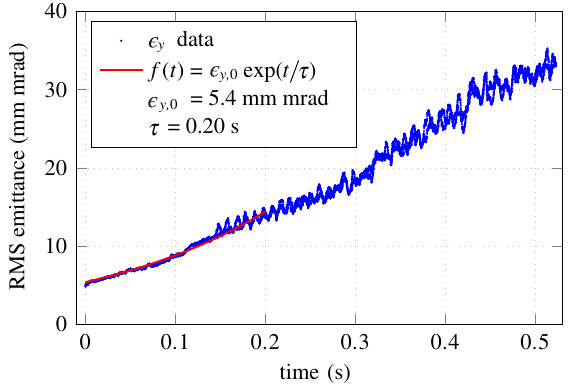
FIG. 20. Growth of the RMS emittance as a result of bunch length jitter as obtained from the tracking simulation. The growth time τ and the initial emittance ϵ y; 0 are free parameters. The curve fit only uses data with t < 0 . 2 s to avoid excessive errors due to the artificially restricted emittance growth of lost shows the evolution of the emittance. While the data do not show a strictly exponential time dependence, applying an exponential fit allows us to extract a growth time of τ ¼ 0 . 20 s for the sake of comparison with the model-based value τ . The latter is higher by a factor of 1.7. theo